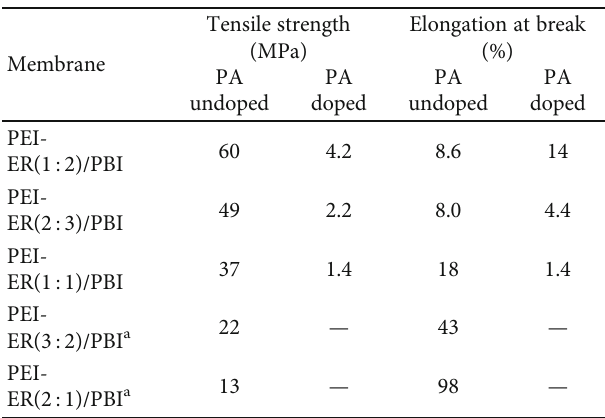
Table 2: Mechanical properties of di ff erent semi-IPN membranes before and after phosphoric acid doping.